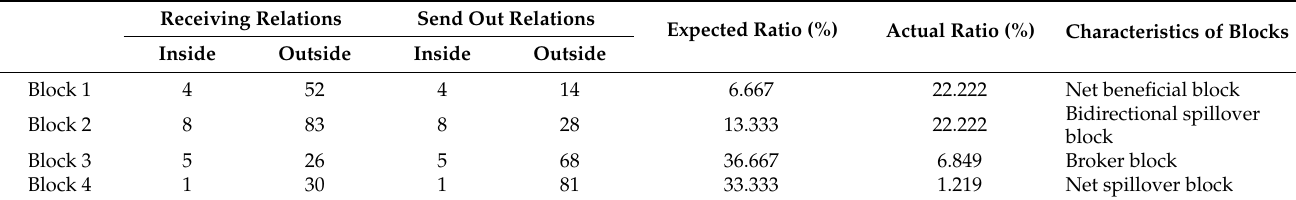
Figure 3. The block health economic spatial network. Table 3. Spillover effects between